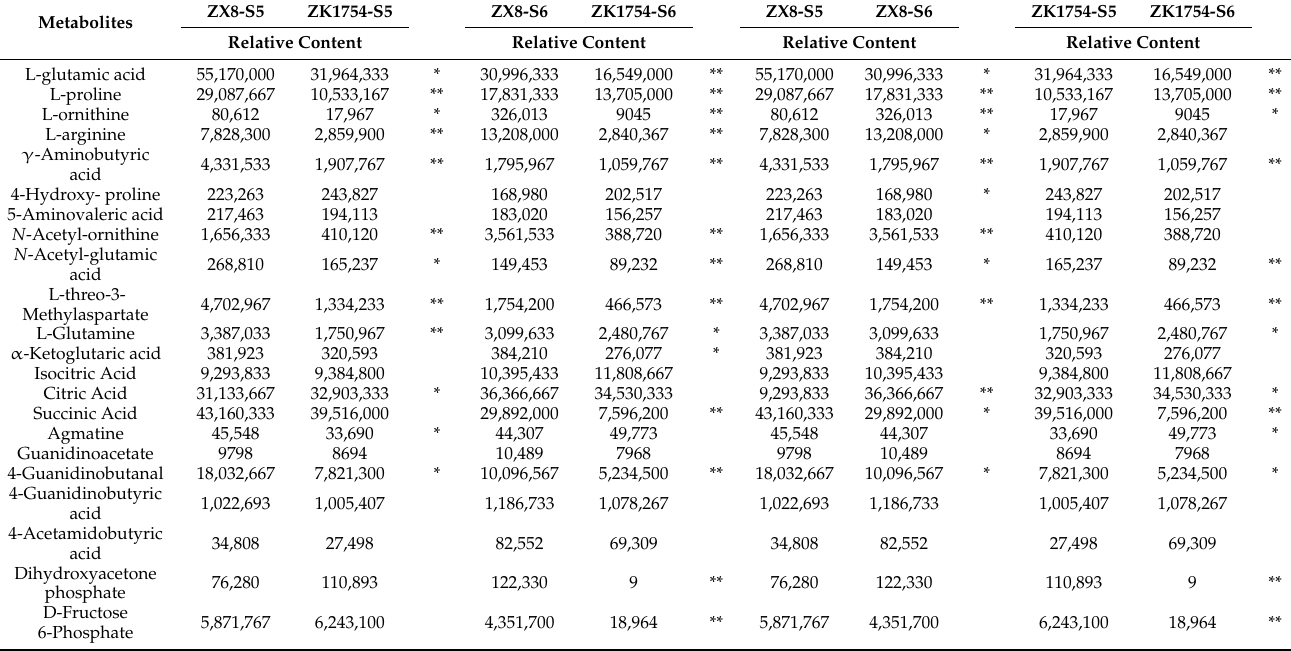
Table 2. Relative contents of amino acids and derivatives in ZX8 and